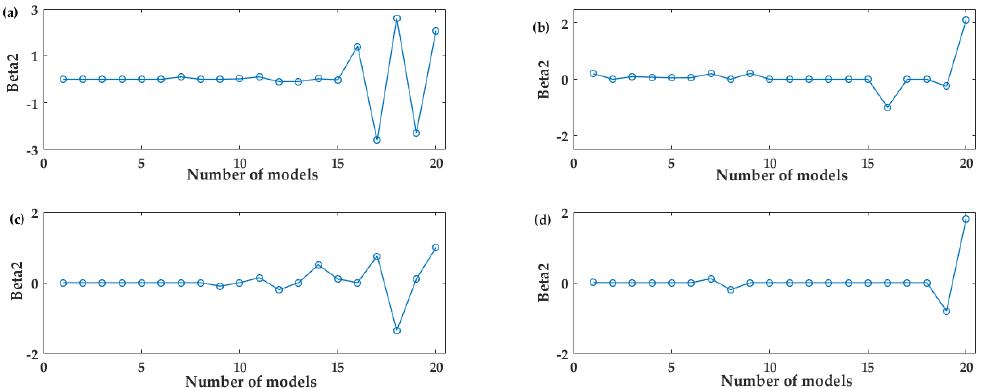
Figure 5. The Beta2 of inputs in the Lasso regression model for ( a ) moisture, ( b ) oil, ( c ) protein, and ( d ) starch of corn.